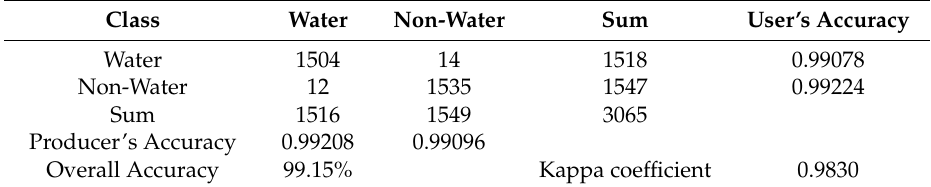
Table 10. Validation statistics of J48 Decision Tree model for water body